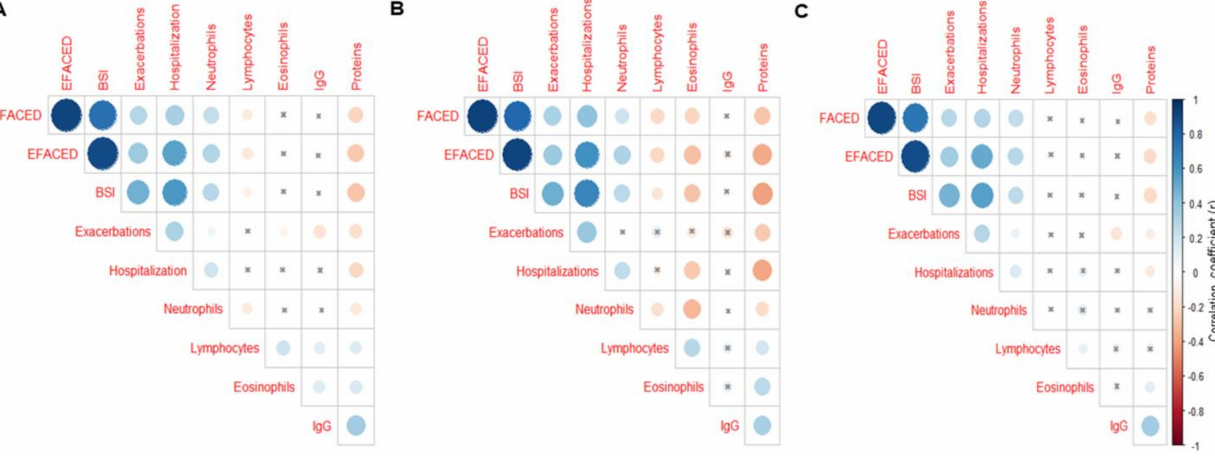
Figure 4. Correlation matrix of the disease severity and analytical variables, in which the positive correlations are represented in blue, while the negative correlations are represented in red: ( A ) all the study patients, ( B ) patients in the below-threshold cluster, and ( C ) patients in the above-threshold cluster. The intersection within the circle represents a p -value > 0.05. The color intensity and the size of the circle are proportional to the correlation coefficients, as indicated in the Y-axis on the right-hand side of the